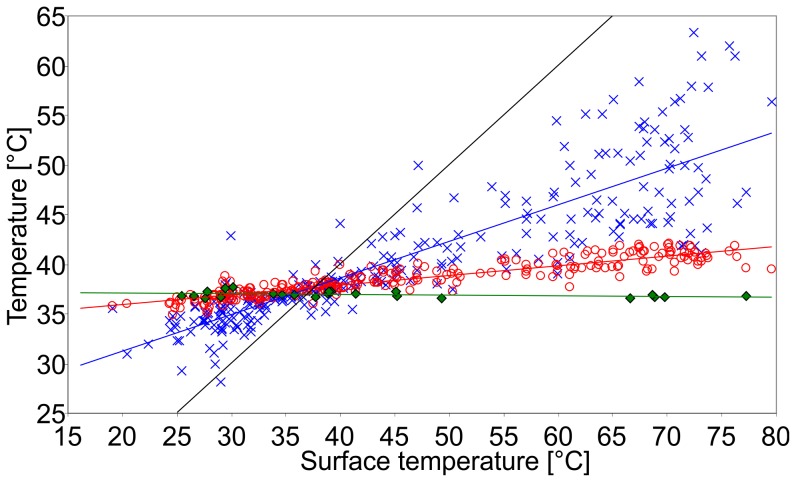
Tbody, Tskin and Tfur of the pups with dry fur.Tbody (green diamonds, green regression line; N = 23), Tskin (red circles, red regression line; N = 279) and Tfur (blue crosses, blue regression line; N = 300) against fur Tsurface (black line) of the pups with dry fur. At Tsurface >40°C, Tskin and Tfur were lower than Tsurface. At Tsurface <35°C, Tskin and Tfur were higher than Tsurface. Tbody was constant at around 37°C (36.9±0.3°C) with a slightly negative slope of regression of −0.006. Tskin and Tfur have slopes of regression of 0.1 (Tskin) and 0.4 (Tfur) and are strongly correlated to Tsurface (p≤0.0001; Tskin: rs = 0.91; Tfur: rs = 0.93), while Tbody is weakly, but not significantly negatively correlated to Tsurface (rs = −0.22; p = 0.32).